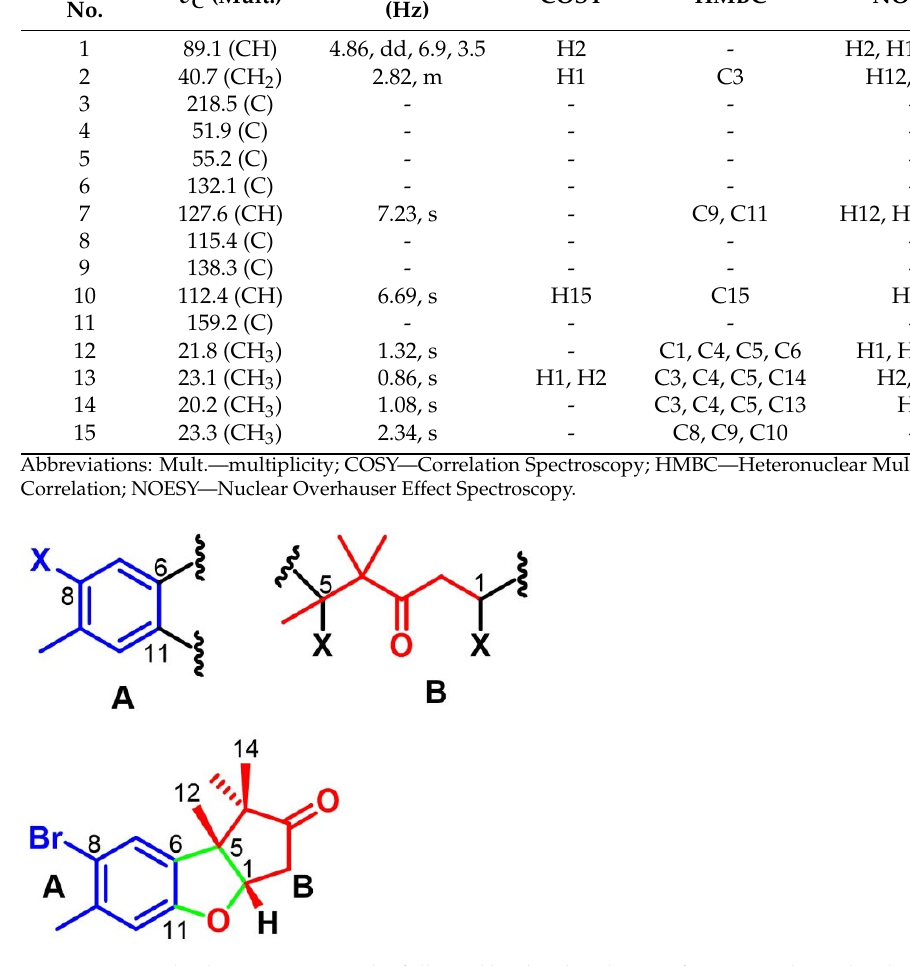
Table 3. NMR spectroscopic data for compound 7.